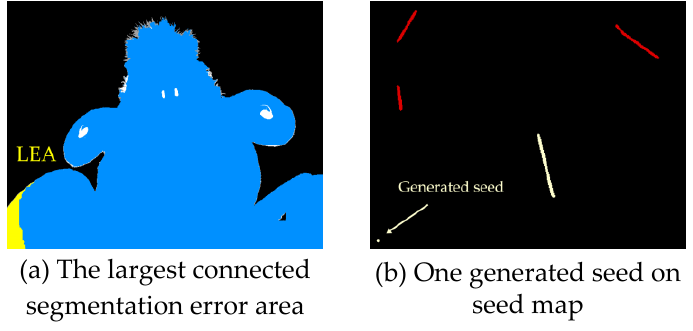
Figure 9. Evaluation on the dataset.